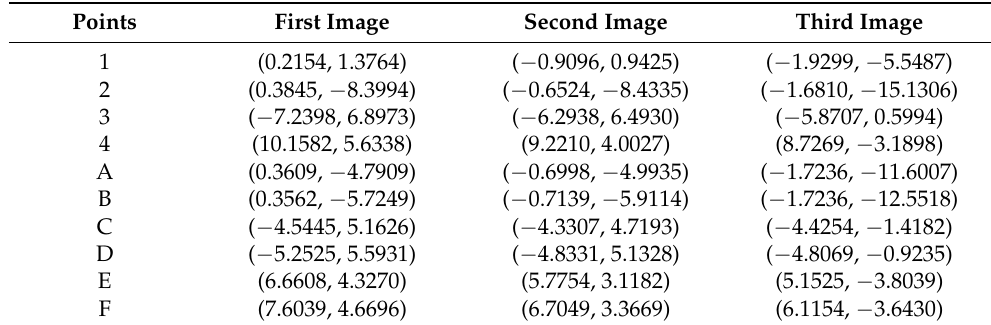
Table 8. Image plane coordinates of the three images.